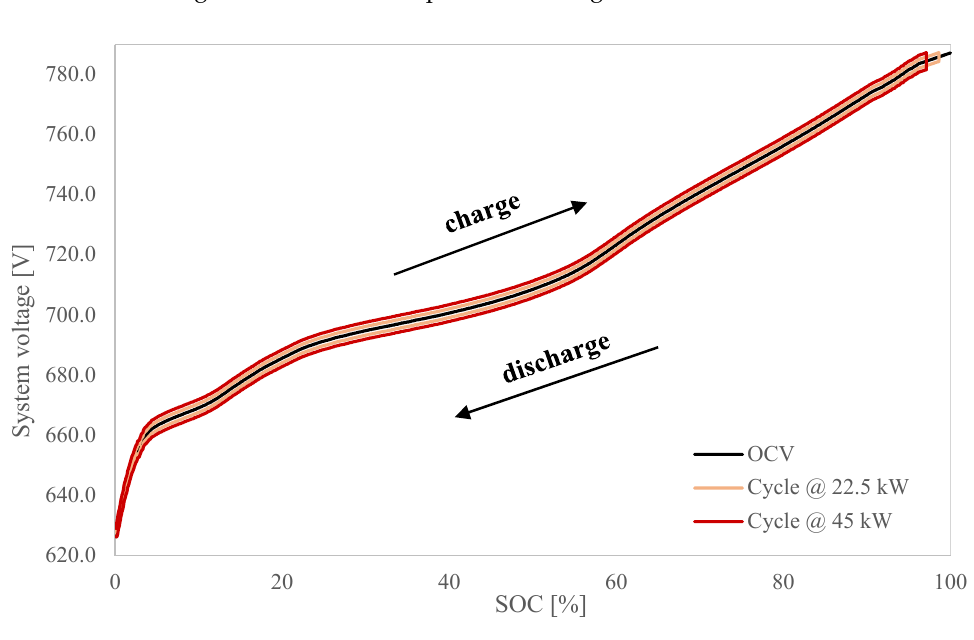
Table 4. Test steps for Set 1.